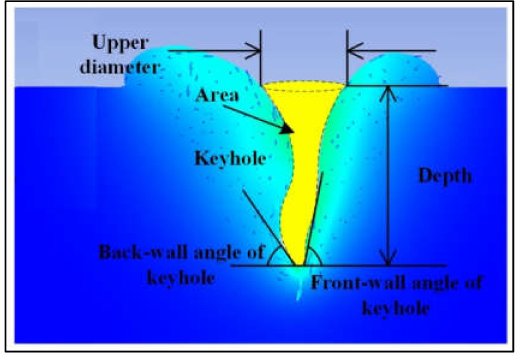
Figure 8. Illustration of keyhole shape with depth, outlet diameter of keyhole top, area of keyhole, front wall inclination angle of keyhole, and back wall inclination angle of keyhole.